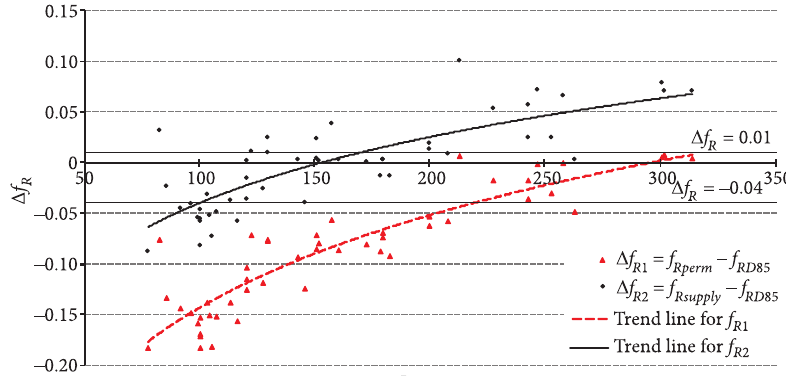
Fig. 6. The differences between supply and demand side friction factors in regard to the curve